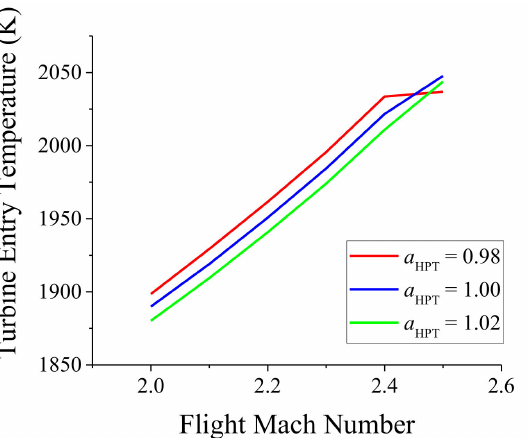
Figure 34. The Variations of Turbine Entry Temperature at the conditions of Different Throat Area Coefficients of High-Pressure Turbine Inlet Guide Vane ( α HPT ).